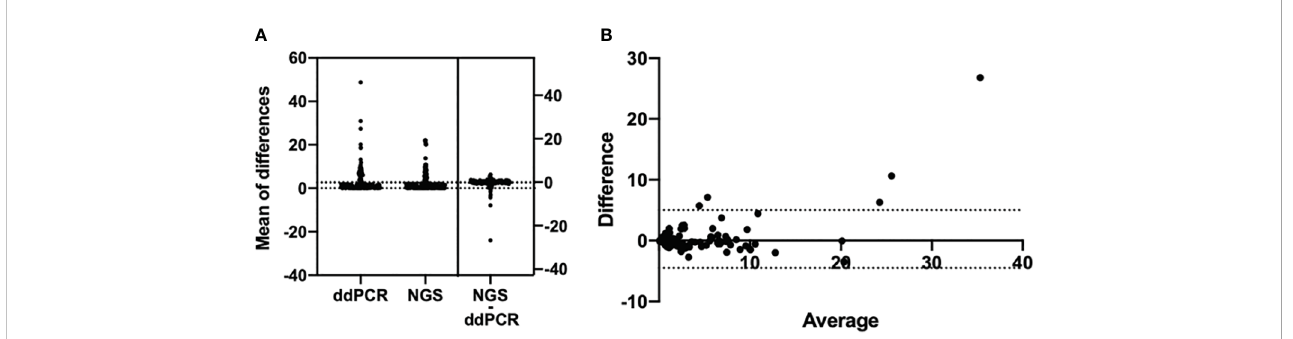
FIGURE 3 Bland – Altman agreement plots of T790M mutation abundance detected by ddPCR assay and NGS. (A) Mean of the differences of 185 T790M-positive samples ’ mutation abundance in both the ddPCR assay and the NGS assay; P -value >0.05, no signi fi cance. (B) Bland – Altman bias of differences between ddPCR assay and NGS assays detected EGFR T790M abundance.